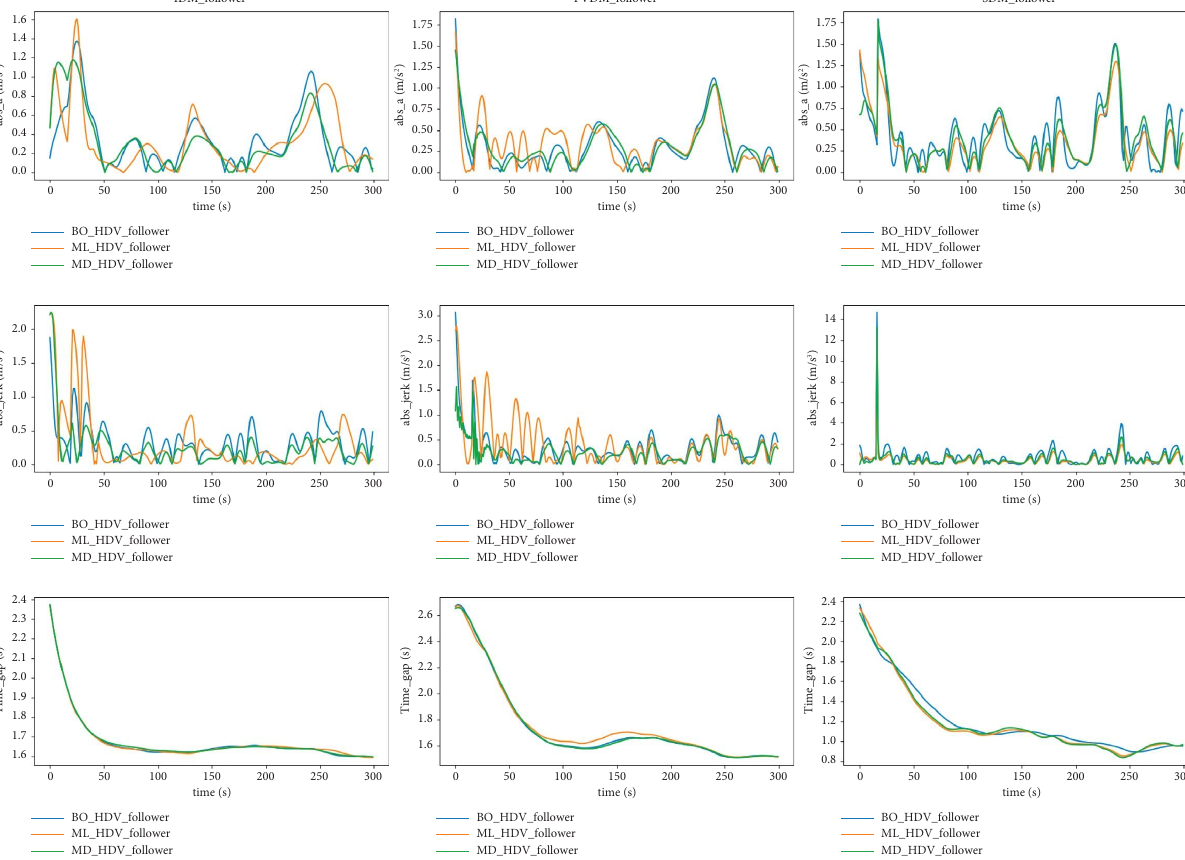
Figure 13: Randomly sampled HDV follower data with diferent driving strategies from DDPG (BO_AV), DDPG (EMI_AV),